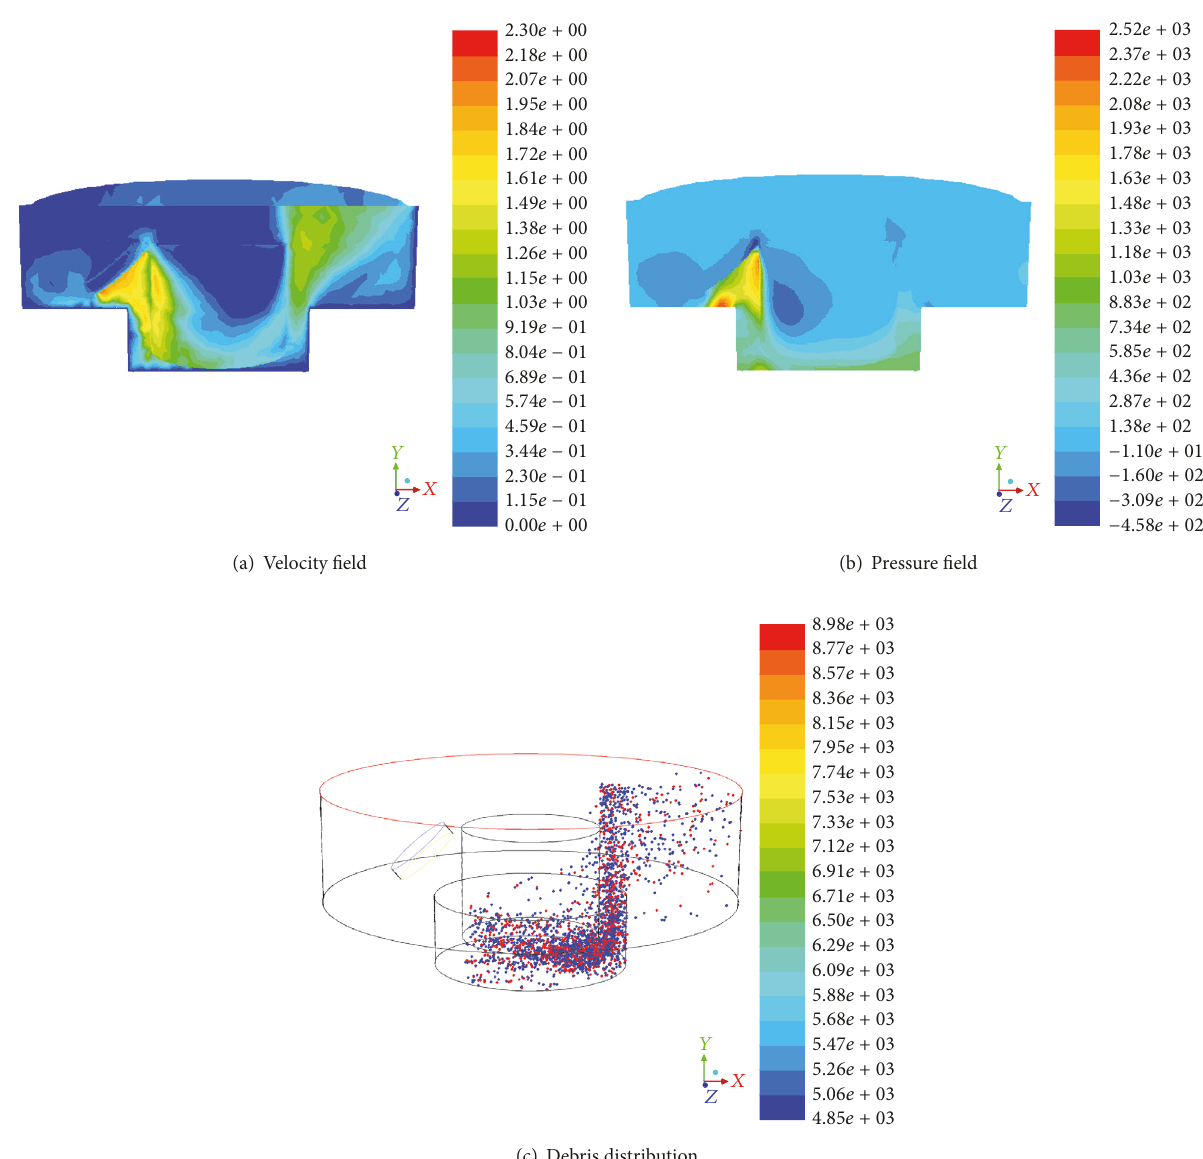
Figure 6: Schematics of gap flow field with flushing at 2m/s and 0.5 mm deep